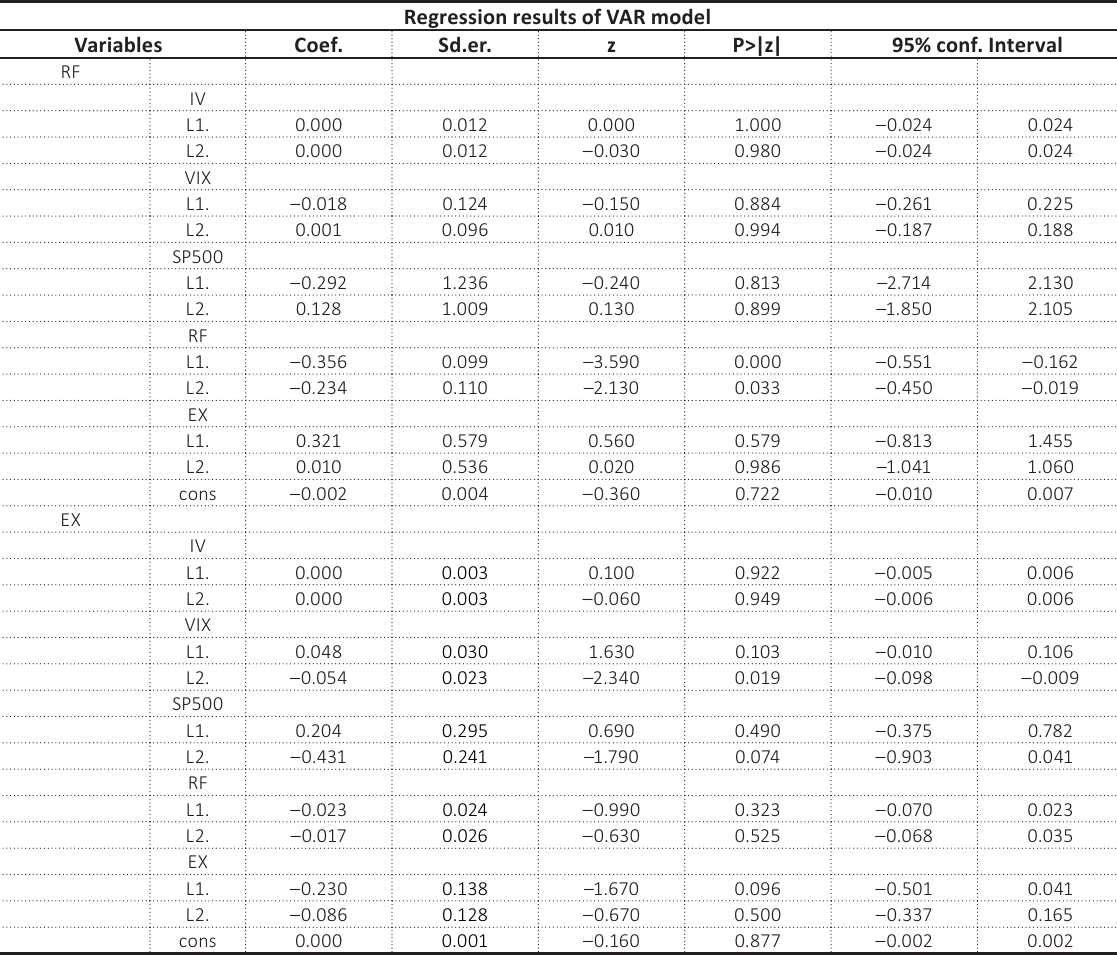
Table A2 (cont.). Vector autoregressive model